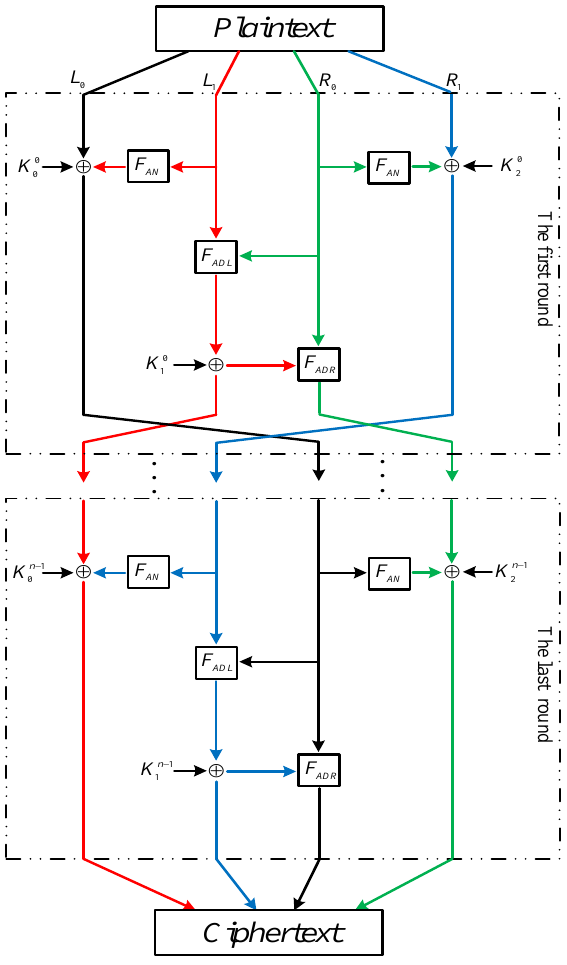
Figure 2. The overall structure of the GFRX